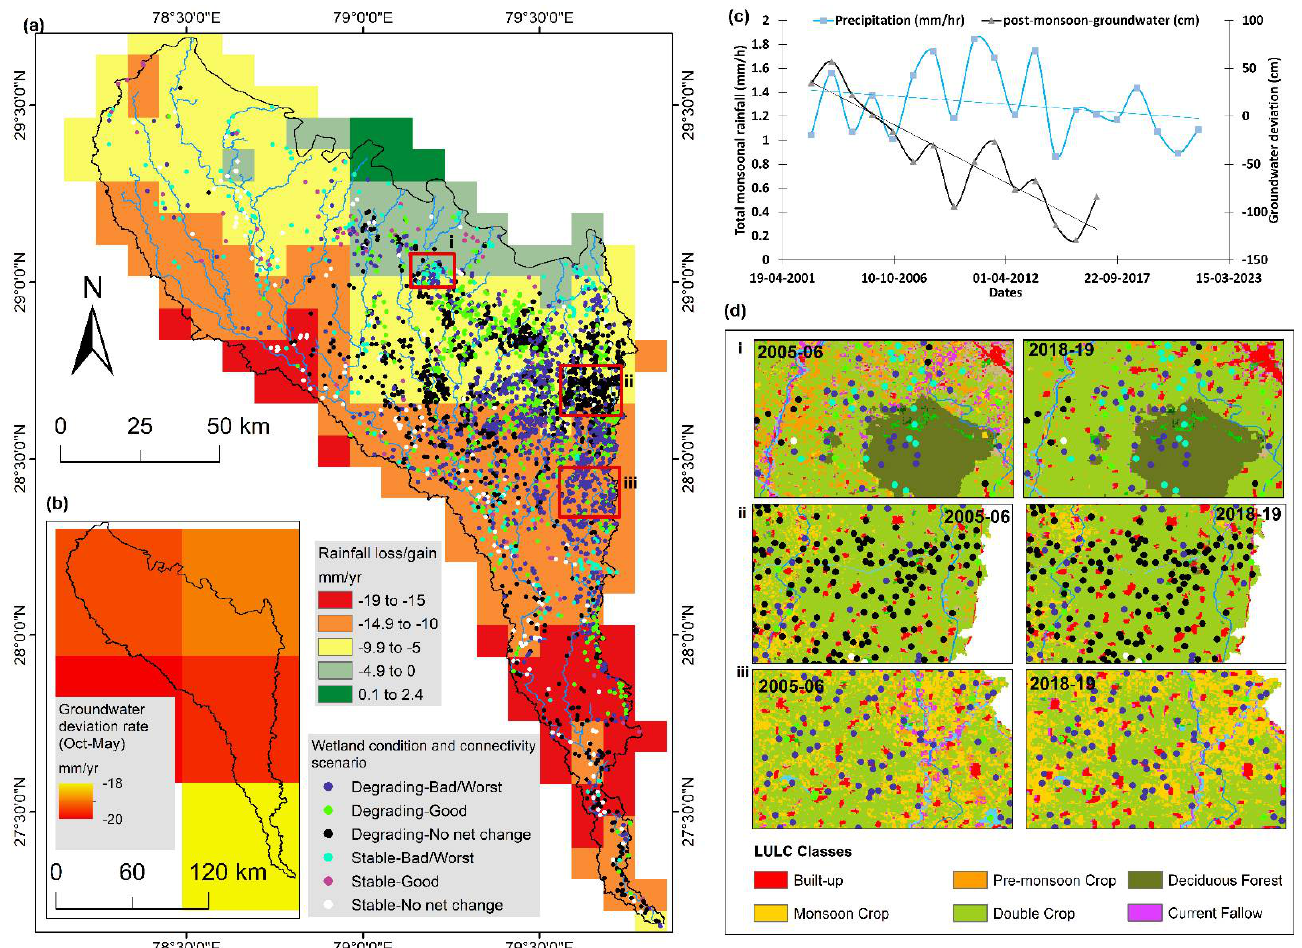
Figure 7. Global precipitation measurement (GPM)-derived monsoonal rainfall trends in the Ram- ganga plains and wetland-connectivity associations. The red boxes i, ii, and iii are the sub-areas for which detailed LULC data was analysed. ( b ) GRACE satellite-based groundwater deviation rates for post-monsoon season Oct–May. ( c ) Precipitation and groundwater trends for whole Ramganga plains—rainfall is total sum for the monsoon months (Jun–Sep) and groundwater is total sum of the post-monsoon months (Oct–May). ( d ) Some insets ( i – iii ) from ( a ) displaying the wetland-connec- tivity associations and LULC in two ends of the LULC time series 2005–2006 and 2018–2019.